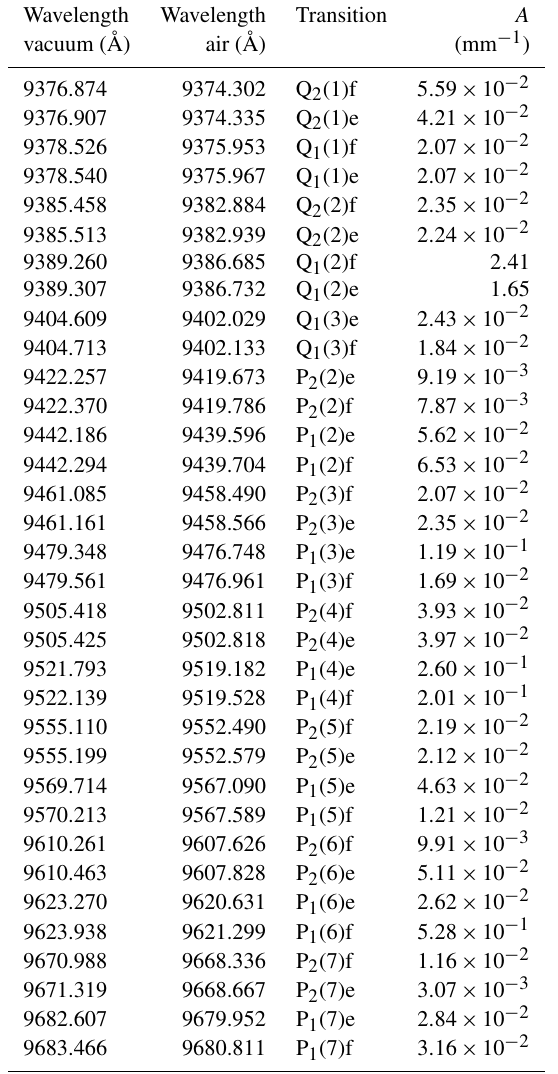
Table 5. Water vapour transmission at wavelengths of OH(8–4) lines. Vacuum wavelengths are from Rousselot et al. (2000), with conversion to air wavelengths undertaken as specified by Ciddor (1996). At each wavelength, water vapour transmission is given by a function of PWV: T λ = exp ( − A × PWV ) , with PWV in